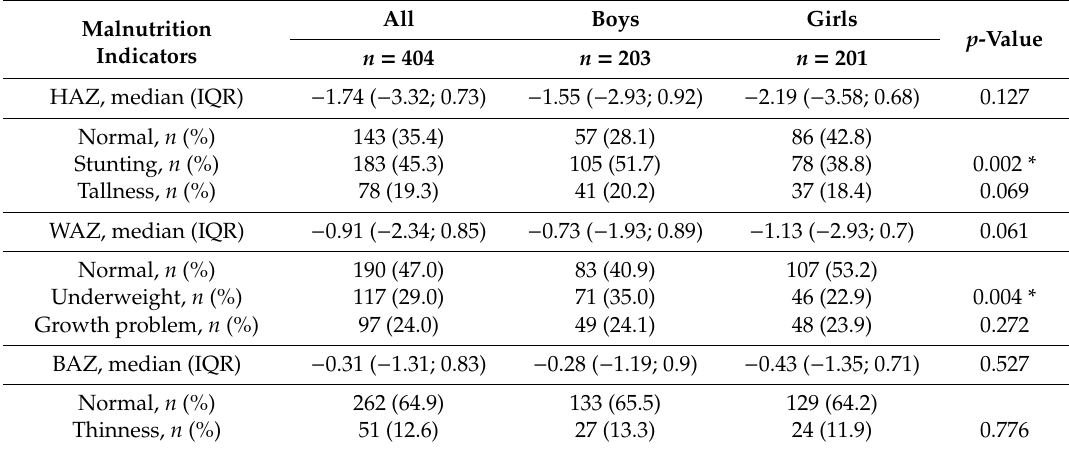
Table 3. Comparison of medians and prevalence of malnutrition indices among children by